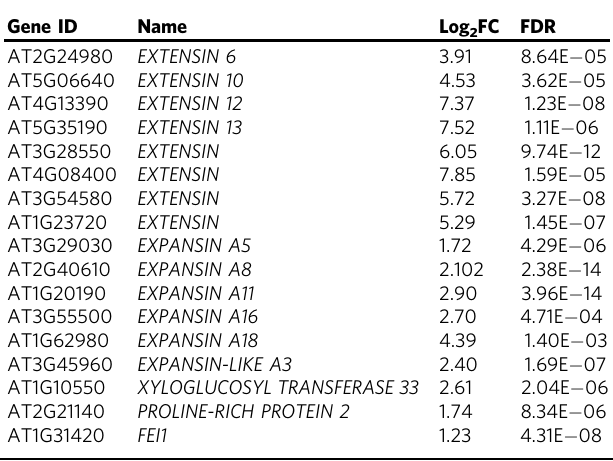
Table 1 Plant cell wall-related genes enriched in